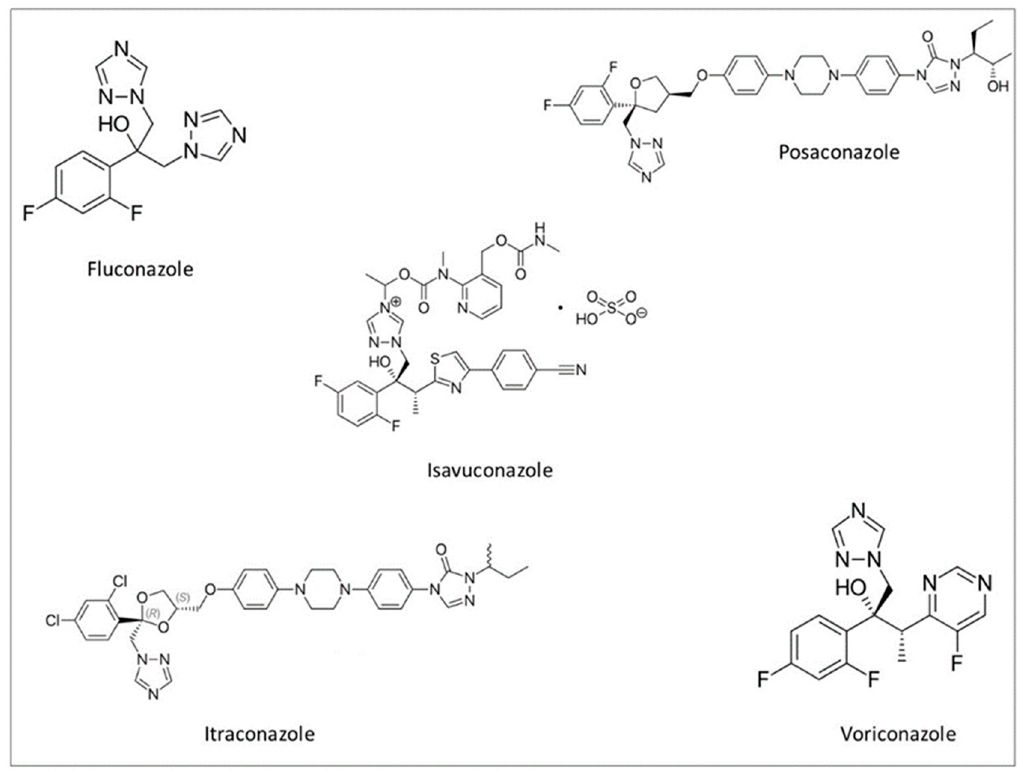
Figure 1. Chemical structure of fluconazole, posaconazole, isavuconazole, itraconazole, and voriconazole .